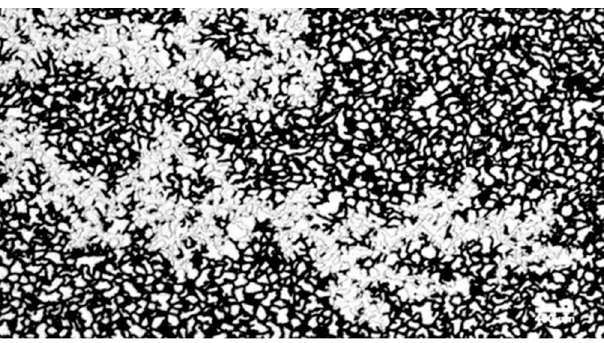
Figure 3. An image of nonwetting fluids (white) displacing wetting fluids (black) in the microfluidic device.